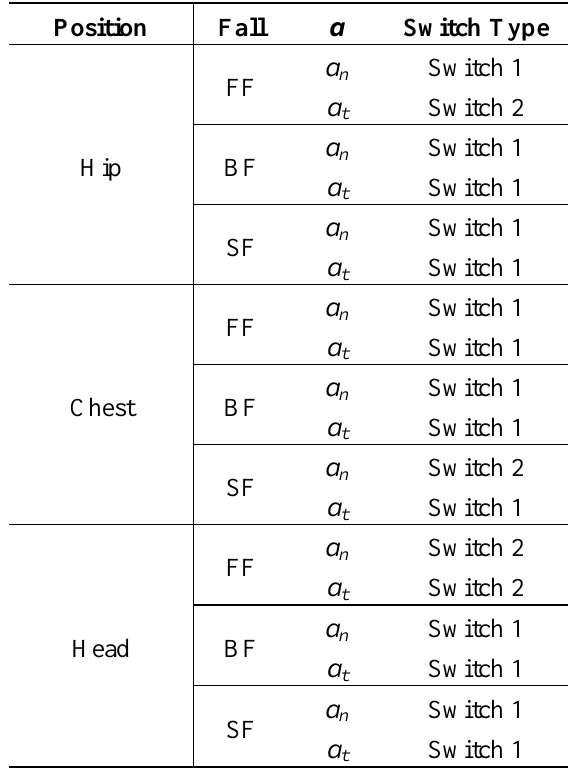
Table 7. Switch types needed for each fall scenario.